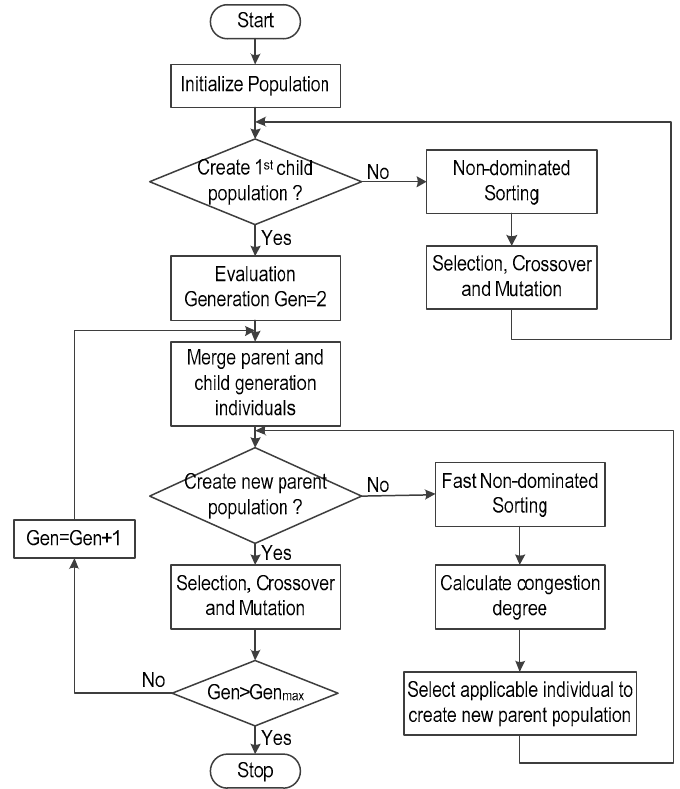
Figure 9. The non-dominated sorting genetic algorithms with elite strategy (NSGA-II) algorithm optimization step.